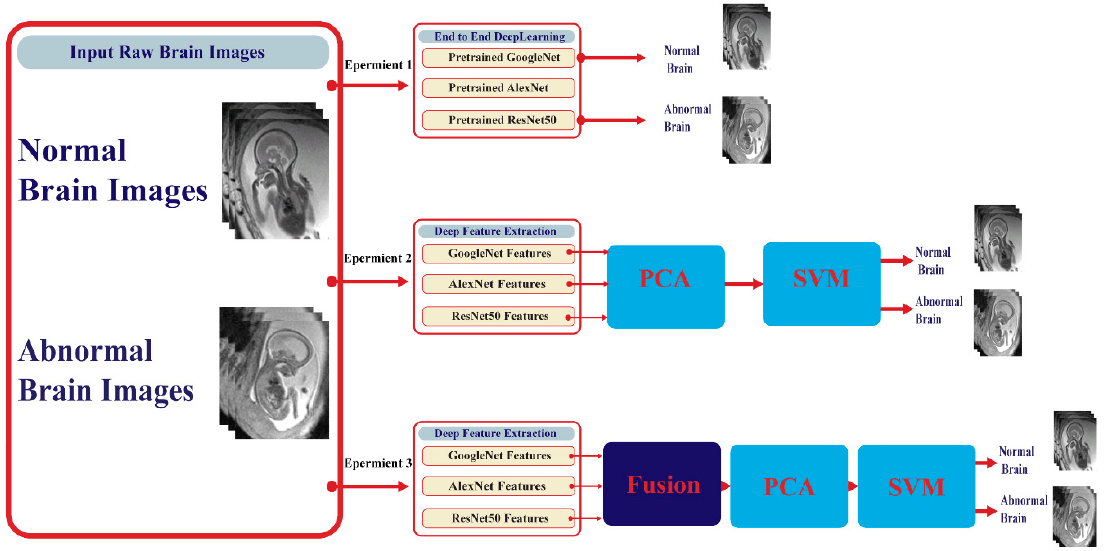
Figure 5. A block diagram of the proposed framework .